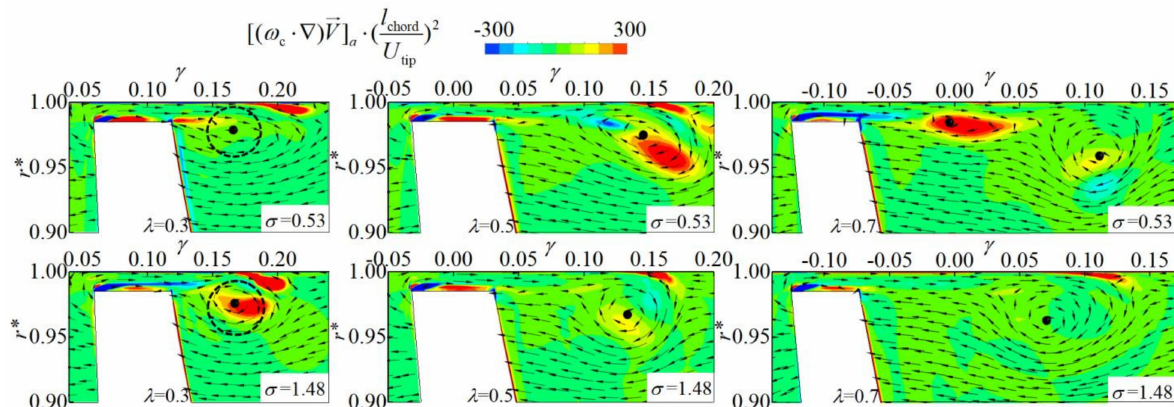
Figure 19. Comparison of the axial bending term distribution on the three planes for the cavitating case ( upper ) and non-cavitating case ( lower ).